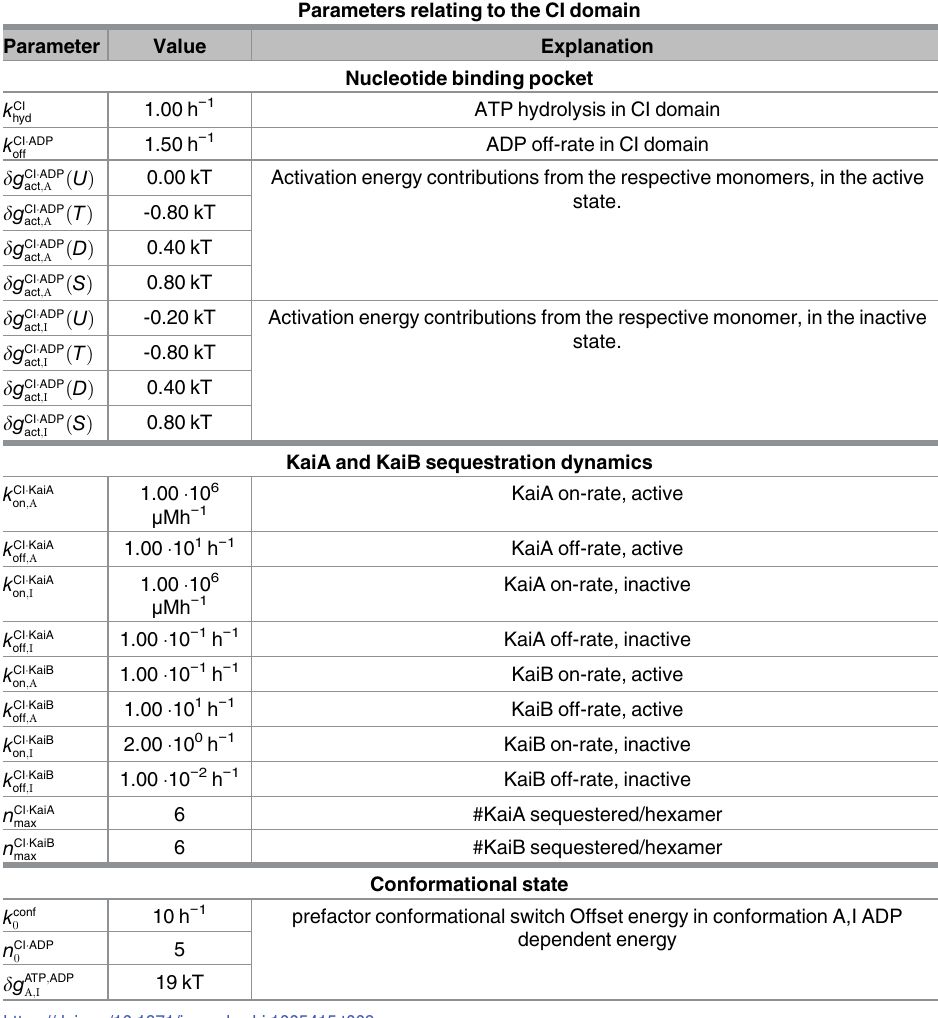
Table 3. Model parameters relating to the CI domain are introduced in the theory section on the power cycle and their values are motivated in the results section. Energiesare given in units of kT, were k is Boltzmann’s constant and T the temperature. Note that the rates of bindingand unbindingof KaiA are for the CI domain.For rates relatingto the CII domain,see Table